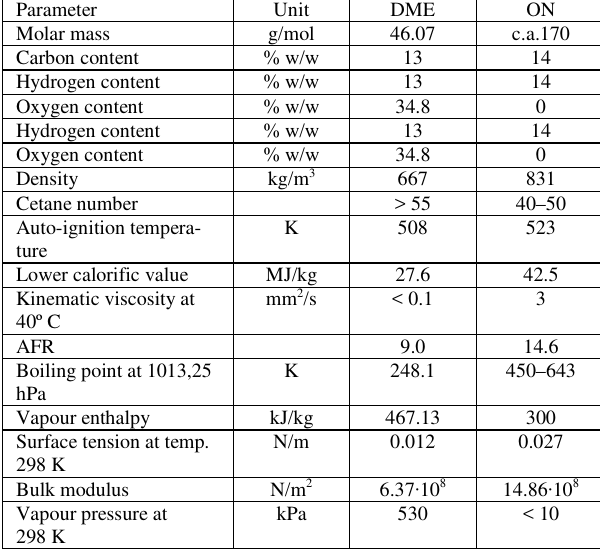
Table 1. Chosen physical and chemical parameters of DME [10, 24, 27]